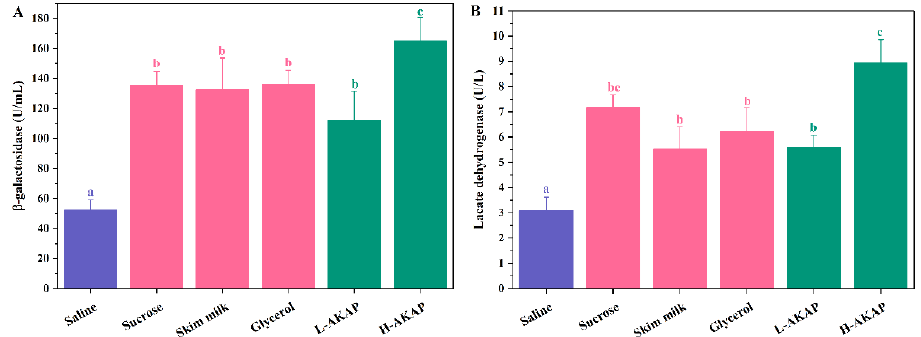
Figure 4. Effects of the negative control (saline), positive controls (1 mg/mL sucrose, 1 mg/mL skim milk, and 20% glycerol), 0.5 mg/mL antifreeze peptides from defatted Antarctic krill (AKAPs) (L-AKAP), and 1 mg/mL AKAP (H-AKAP) on the ( A ) β -galactosidase ( β -GAL) activity and ( B ) lactic dehydrogenase (LDH) activity of L. rhamnosus after freezing. Bars with different lowercase letters (a, b, and c) indicate significant differences ( p < 0.05).